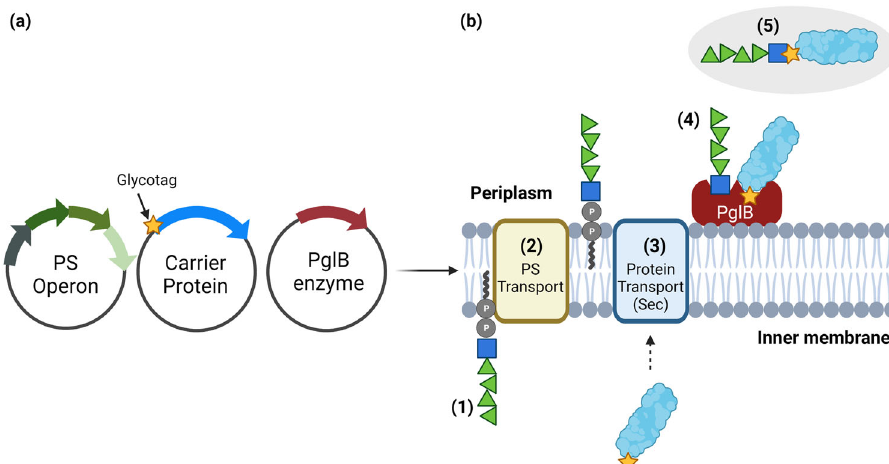
Fig. 3 Glycoconjugate production using C. jejuni PglB bioconjugation inside E. coli host cells. a Plasmids containing genes encoding polysaccharide (PS) biosynthesis (green), the protein acceptor (blue) containing a glycotag (yellow star), and the oligosaccharyltransferase (OST) PglB (red) are co-transformed into E. coli host cells. b Bioconjugates are produced as follows; (1) The PS biosynthesis locus is expressed and built onto undecaprenol-pyrophosphate (Und-PP) lipid linkers within the inner membrane. (2) The PS is fl ipped from the cytoplasm to the periplasm by a speci fi c fl ippase enzyme. (3) Synthesised carrier proteins are exported to the periplasm through the Sec secretion system. (4) In the periplasm both the PS, and the carrier protein containing a speci fi c glycotag can be recognised by the PglB OSTenzyme. PglB transfers the PS from Und-PP onto the asparagine residue within the glycotag D/E-X-N-X-S/T motif on the fully folded carrier protein, resulting in protein glycosylation. (5) An inexhaustible supply of glycoproteins can be subsequently puri fi ed from E. coli